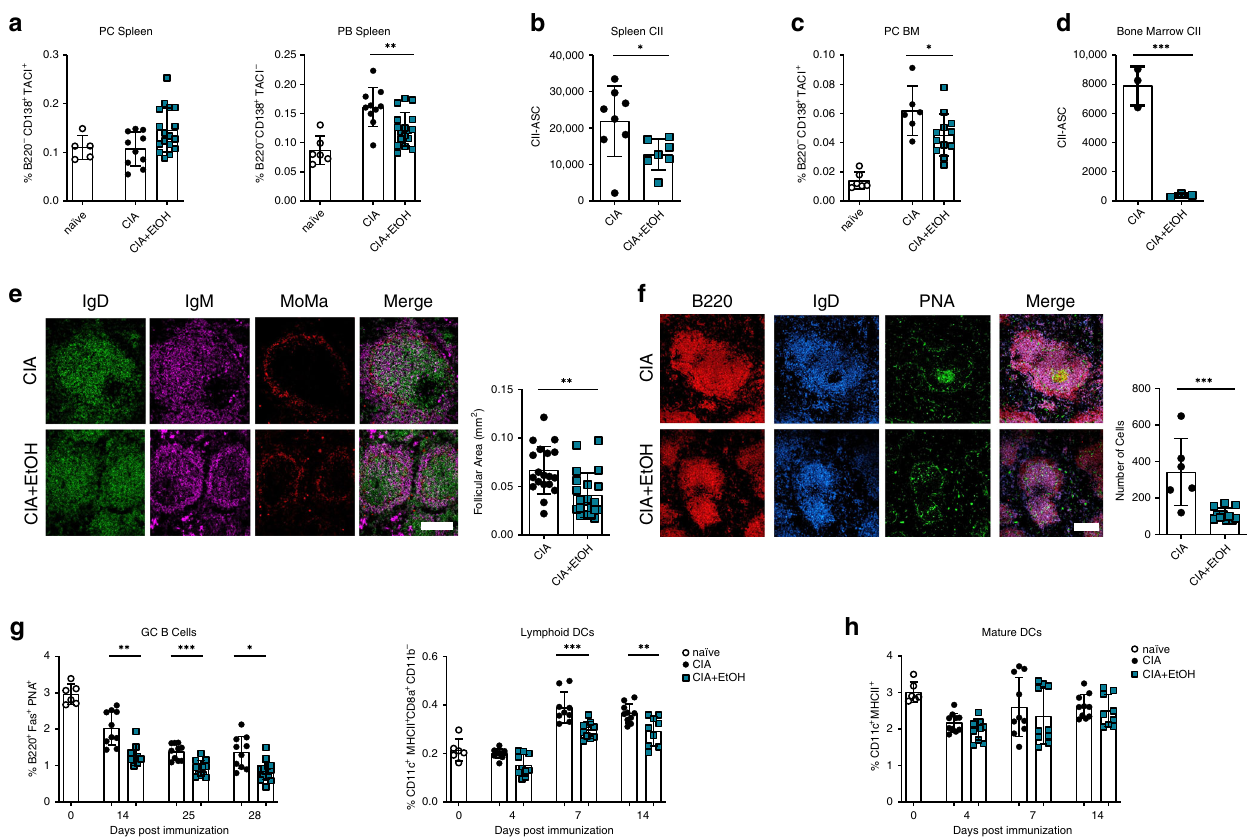
Fig. 4 Alcohol exposure has pronounced effects on germinal center B cells. a Percentage of splenic plasma cells (B220 - CD138 + TACI + ) and plasmablasts (B220 − CD138 + TACI − ) of naïve mice ( n = 6 mice) and mice induced for CIA and exposed to vehicle (CIA, n = 10 mice) or alcohol (CIA + EtOH, n = 17 mice). b total splenic CII speci fi c cells determined via ELISpot (CIA, n = 8 mice, CIA + EtOH, n = 7 mice), c percentage of bone marrow plasma cells (B220 − CD138 + TACI + ) (naive n = 6 mice, CIA, n = 6 mice, CIA + EtOH, n = 12 mice) and d total bone marrow CII speci fi c cells determined via ELISpot in mice induced for CIA and exposed to vehicle (CIA, n = 3 mice) or alcohol (CIA + EtOH, n = 3 mice). e Representative immuno fl uorescence images of spleens from mice induced for CIA and exposed to vehicle (CIA, n = 7 mice) or alcohol (CIA + EtOH, n = 8 mice) at 28 dpi. Quanti fi ed by Image J area measure tool. Cryosections were stained for B cell follicle by IgG (green), IgM (magenta), and MoMa (red). Scale bar, 100 μ m. f Representative immuno fl uorescence images of splenic cryosections for identi fi cation of germinal center B cells with B220 (red), IgD (blue), and PNA (green). Quanti fi ed by the average number of B220 + PNA hi cells (CIA, n = 6, CIA + EtOH, n = 12 mice). Scale bar, 200 μ m. g Flow-cytometry analysis of splenic germinal center B cells (B220 + Fas + PNA + ) and lymphoid dendritic cells (CD11c + MHCII + CD8a + CD11b − ) as well as h mature dendritic cells (CD11c + MHCII + ) of naive mice ( n = 6 mice) and mice induced for CIA and exposed to vehicle (CIA, n = 10 mice) or alcohol (CIA + EtOH, n = 10 mice). N number represents number of animals used per experiment. Data shown from one of three independent experiments and expressed as mean ± SD. Statistical difference was determined by two-way ANOVA ( g , h ) Students two-tailed t -test ( a , b , c , d , e , f ). * p < 0.05; ** p < 0.01; *** p <